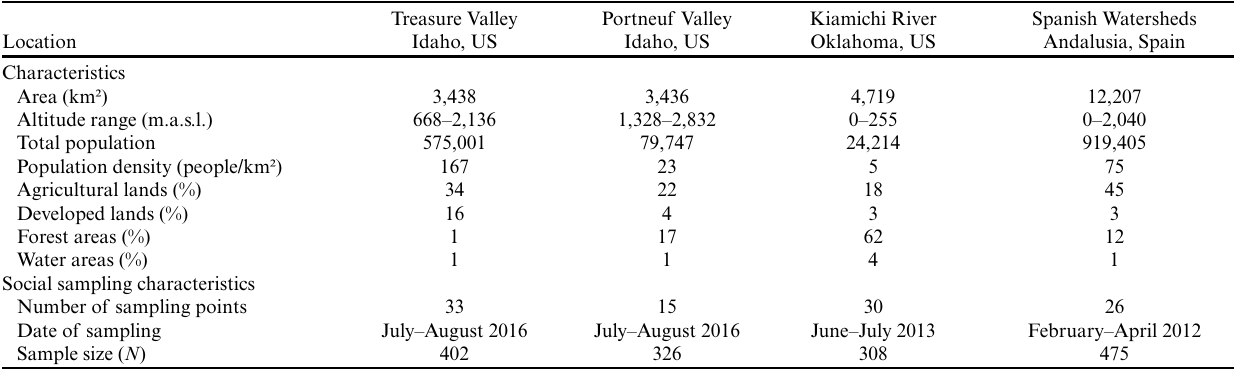
Table 1. Summary of environmental characteristics and social sampling of the four place-based research